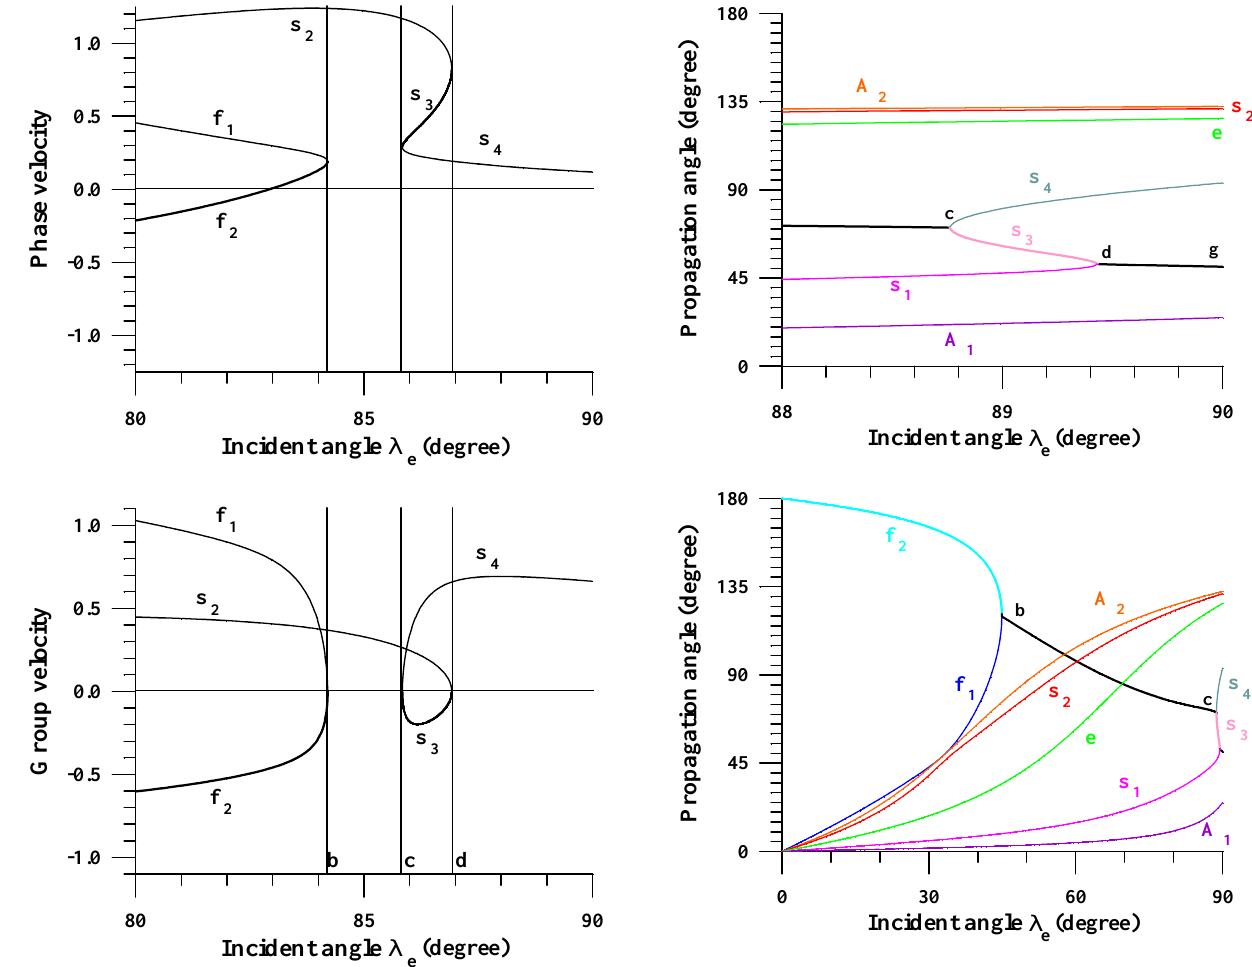
Fig. 7. X -components of the phase velocity (the upper plot) and group velocity (the lower plot) of magnetoacoustic waves as a func- tion of the incident angle, changing from 80 up to 90 ◦ . All velocities are normalised by the normal component of the flow velocity V x 2 behind the shock wave. Calculations are performed for the waves having the propagation angles shown in Fig. 6.